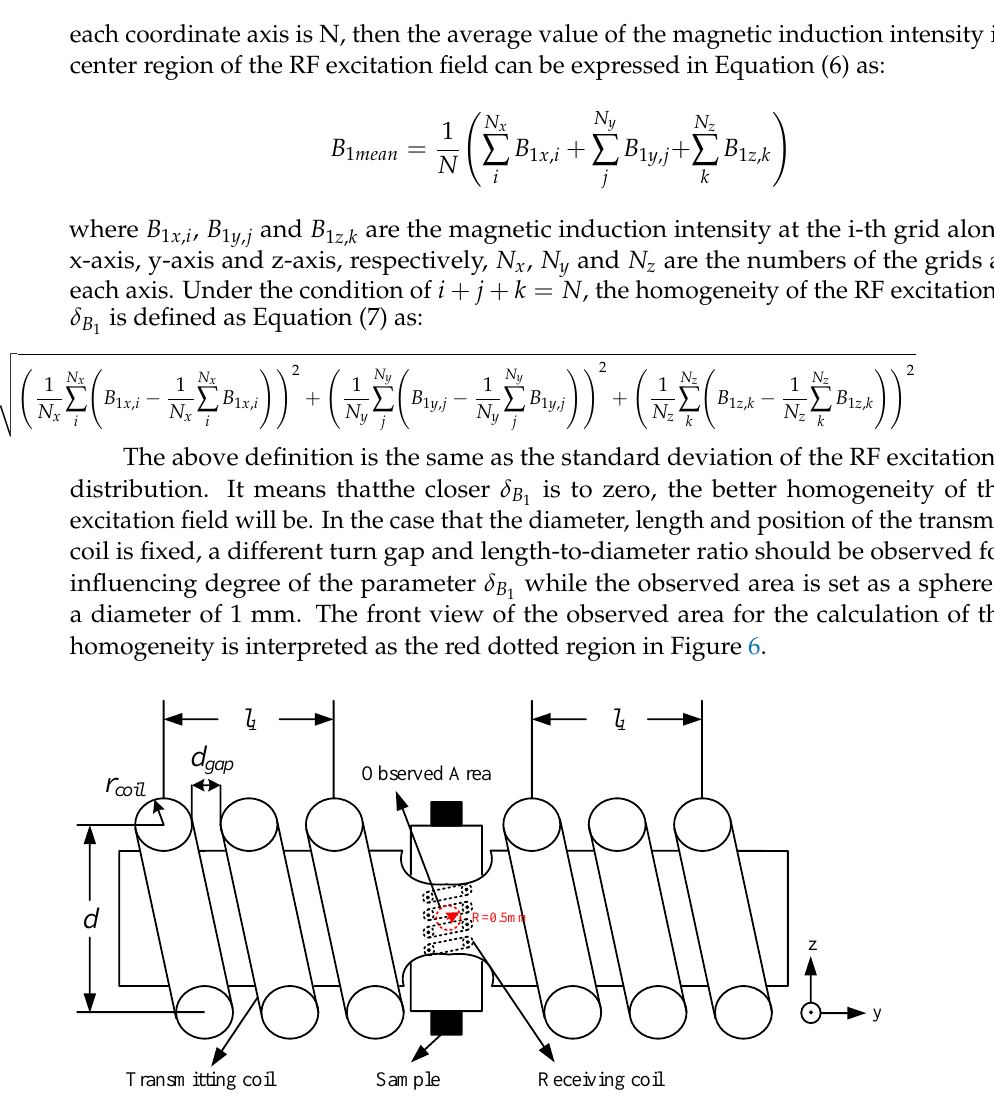
Figure 6. The front view of the observed area for the calculation of the RF excitation field homogeneity. The homogeneity δ B of the RF excitation field corresponding to the turn gap is 1 displayed in Table 1. It can be concluded that δ B reaches a minimum value when the 1 equation d gap = d coil is established. Table 1. Homogeneity of the RF excitation field corresponding to the turn gap. d gap The homogeneity δ B of the RF excitation field corresponding to the length-to-diameter 1 ratio is shown in Table 2. The results show that δ B reaches a minimum value while the 1 length-to-diameter ratio l / d is 0.5 rather than the maximum ratio 0.8. The reason is that the two-part structure of the transmitting solenoid is more similar to a multi-turn Helmholtz